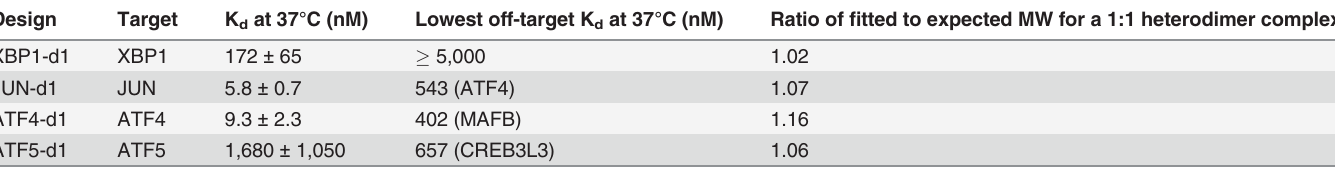
Table 4. Molecular weights of designed bZIP complexes determined by analytical ultracentrifugation.